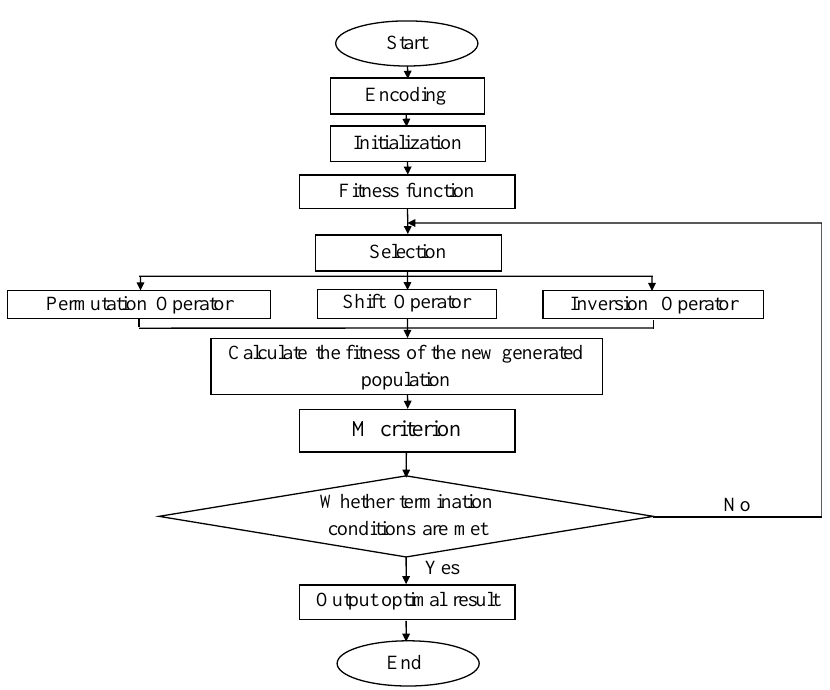
Figure 2. The flow chart of annealing parthenogenetic algorithm